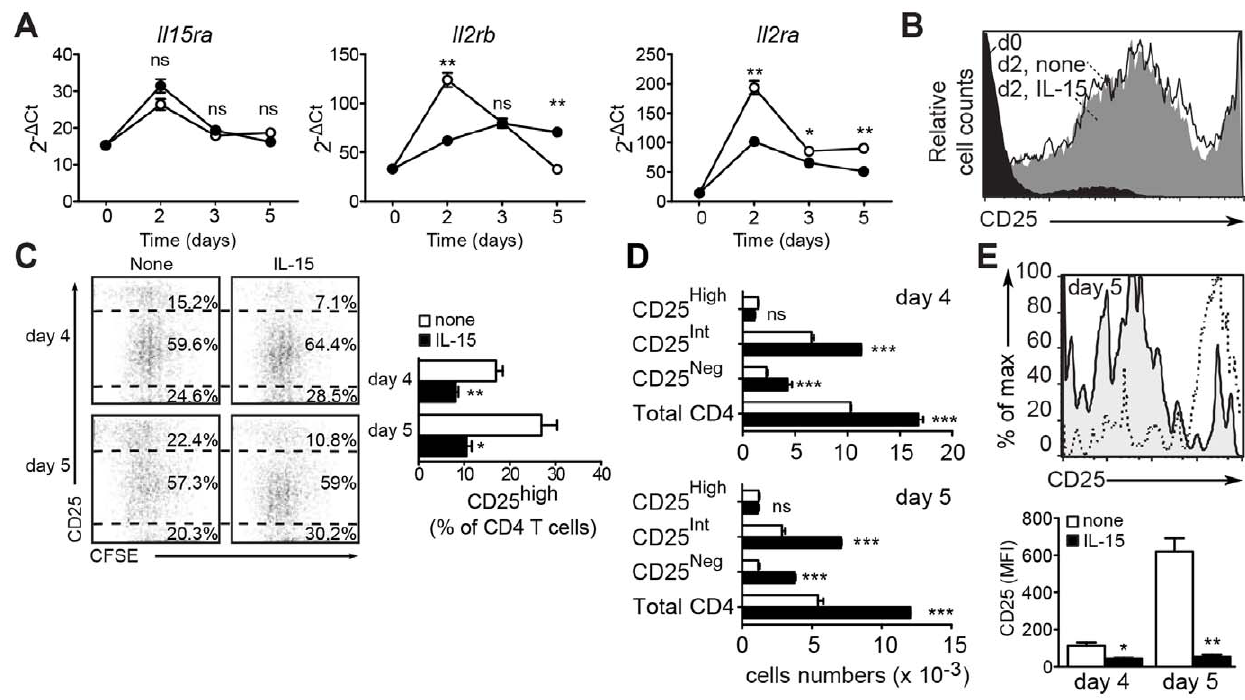
Figure 4. Exogenous IL-15 decreases the fraction but not the absolute number of CD25 High CD4 + T cells. ( A ) IL-15 alters TCR-induced gene expression of IL-2 and IL-15 receptor subunits. Purified CD4 + T cells were stimulated with 0.1 m g/ml anti-CD3 mAb and irradiated TdACs in the absence (white circles) or presence (black circles) of 3 ng/ml IL-15. At the indicated time points, CD4 + T cells were purified for PCR analysis of indicated gene transcripts and expressed as 2 2 D Ct where D Ct=Ct target gene - mean Ct normalization genes . Statistical significance was calculated using student t-test: ns=not significant, ** P , 0.01, *** P , 0.001. ( B ) Spleen CD4 + T cells were left unstimulated or stimulated with anti-CD3 in the presence or absence of IL-15 for two days, as indicated. Shown are histogram overlays of CD25 expression, gated on viable CD4 + T cells (d: day). ( C ) CFSE- labeled CD4 + T cells were stimulated with 0.1 m g/ml anti-CD3 and irradiated TdAC, without or with 3 ng/ml IL-15 for four or five days. Shown are flow cytometry dot plots of CFSE dye dilution versus CD25 expression in the viable CD4 + gate (left, shown percentages were calculated on viable CD4 + T cells) and summarizing bar graph of the CD25 high fraction (left). Statistical significance was calculated using student t-test: * P , 0.05, ** P , 0.01. ( D ) Absolute numbers of viable CD25 High , CD25 Int , CD25 Negative and total CD4 + T cells, as determined by flow cytometry using micro-beads as reference. White and black bars represent stimulation with anti-CD3 in the absence or presence of 3 ng/ml rhIL-15, respectively. Statistical analysis was calculated using 2-way ANOVA and Bonferroni posttest: ns=not significant, *** P , 0.001. Data shown are representative of three independent experiments. ( E ) CFSE-labeled CD4 + T cells were stimulated as in B . Shown are histogram overlays (top) of CD25 expression of the last generation of viable CD4 + T cells (by CFSE dilution) on day 5 after stimulation in the absence (dashed line) or presence (shaded) of 3 ng/ml rmIL-15. Bar graph (bottom) represents the mean fluorescenceIntensity of CD25 expression in the last generation, as shown in the overlays. Statistical significance was calculated using student t-test: * P , 0.05, ** P ,